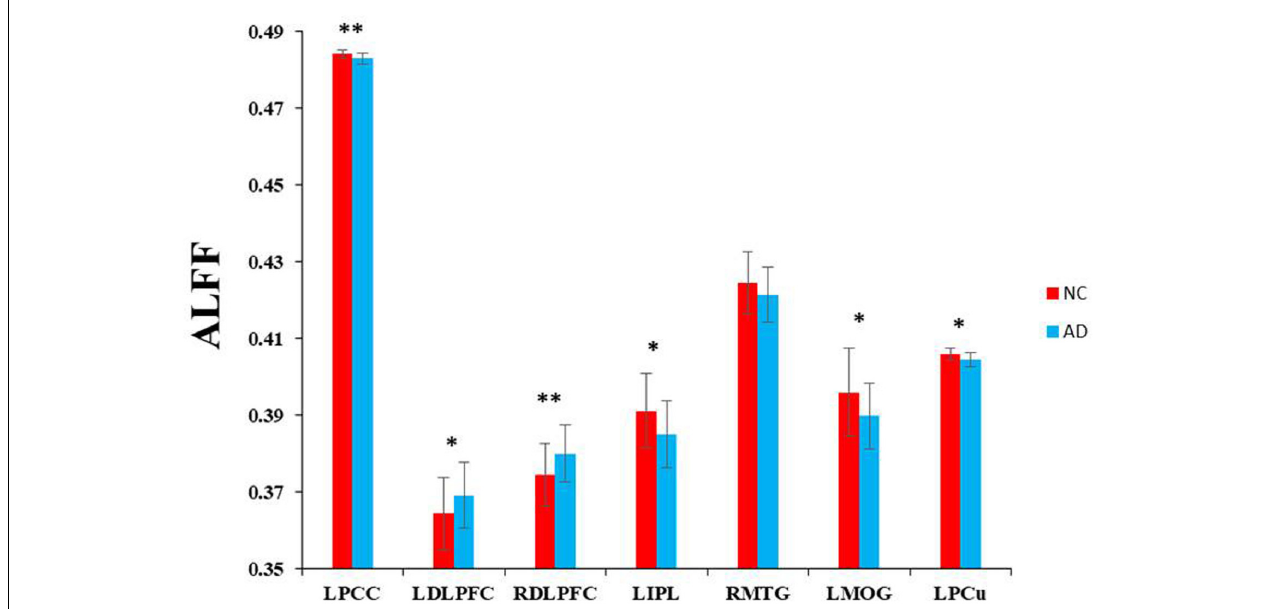
FIGURE 3 | Voxel-wise ALFF changes in patients with AD compared with healthy controls in specific regions which were significantly decreased in rCBF. ∗∗ Represents significantly changed ALFF in the AD patients compared with healthy controls ( P < 0.01). ∗ Represents slightly changed ALFF ( P < 0.05).